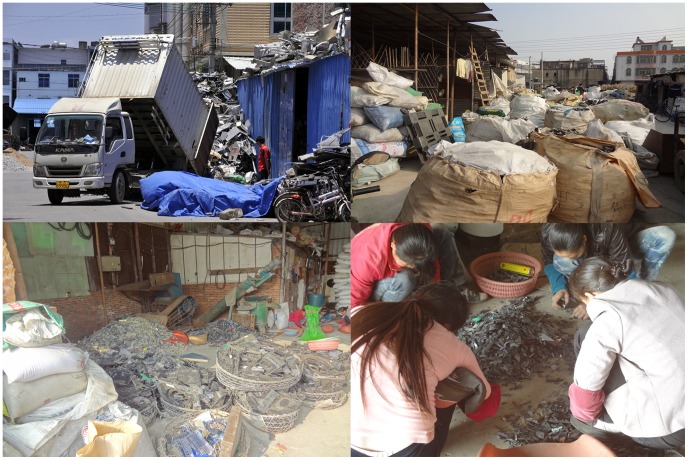
The current status of e-waste processing in Guiyu.